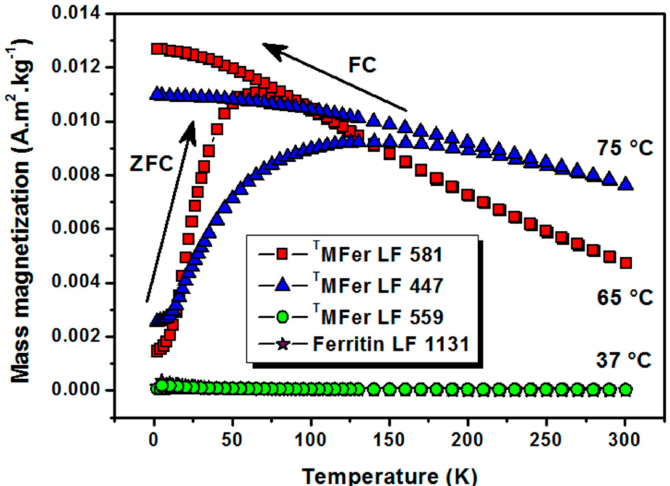
Figure 4. Thermomagnetic curves after cooling at zero magnetic field (ZFC)/under 7.96 kA/m magnetic field (FC) for magnetoferritin. T MFer with LF: 581, 447 and 559 was prepared at various synthesis temperatures marked on the graph (37, 65, and 75 ◦ C). T prefix in T MFer labeling was used for specification of magnetoferritin samples prepared at three different synthesis temperatures with similar loading factor